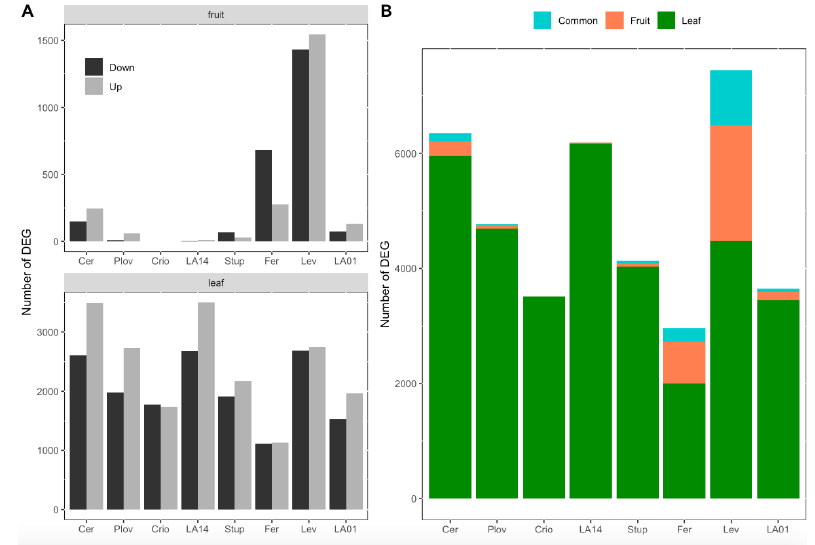
Figure 3. Number of differentially expressed genes (DEGs) per genotype and organ. ( A ) Number of down- and upregulated genes in response to water deficit in fruit (top) and leaves (down). ( B ) Proportion of genes that were significantly differentially expressed in response to water deficit in leaves only (green), in fruit only (red) or in both organs (blue). The eight genotypes were ordered according to their genetic group, the first four genotypes being cherry accessions (SLC) and the last four, large fruit accessions (SLL).